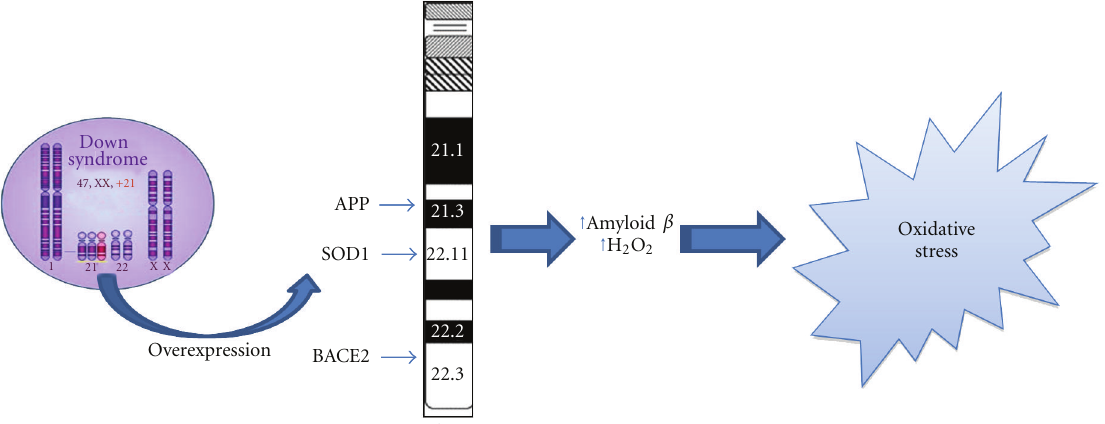
Figure 1: Oxidative stress and down syndrome. Increased conditions of oxidative stress are caused by the overexpression of some of the genes encoded by Chr21. Among these, amyloid precursor protein (APP), copper-zinc superoxide dismutase (SOD1), and beta secretase (BACE2) can directly or indirectly lead to